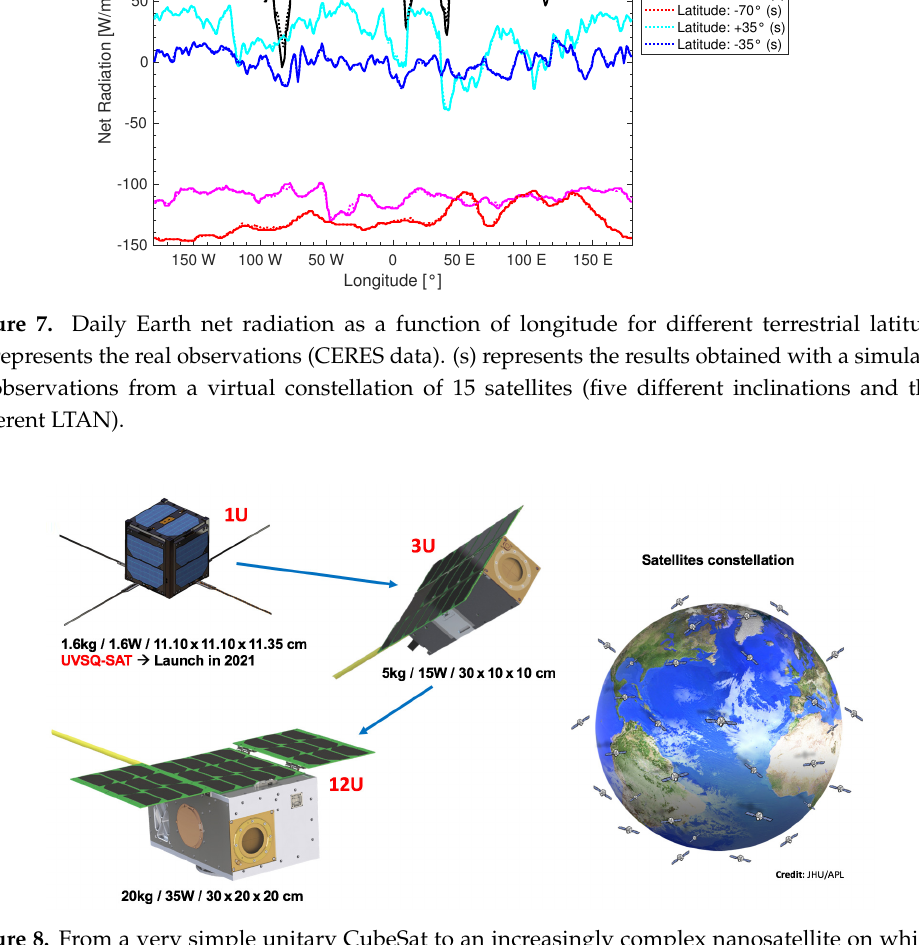
Figure 8. From a very simple unitary CubeSat to an increasingly complex nanosatellite on which a small satellite constellation will be